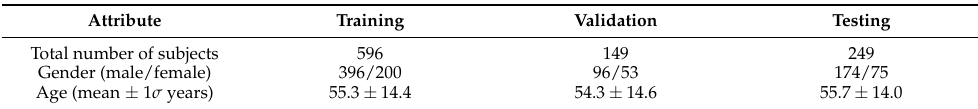
Table 2. Total number of subjects and related demographics in different